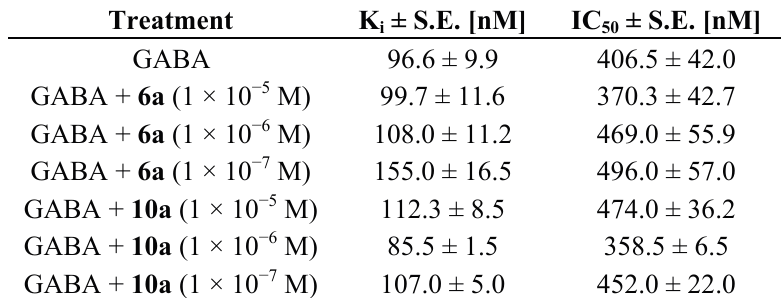
Table 5. Effect of 6a and 10a on affinity of γ -aminobutyric acid (GABA) to GABA A